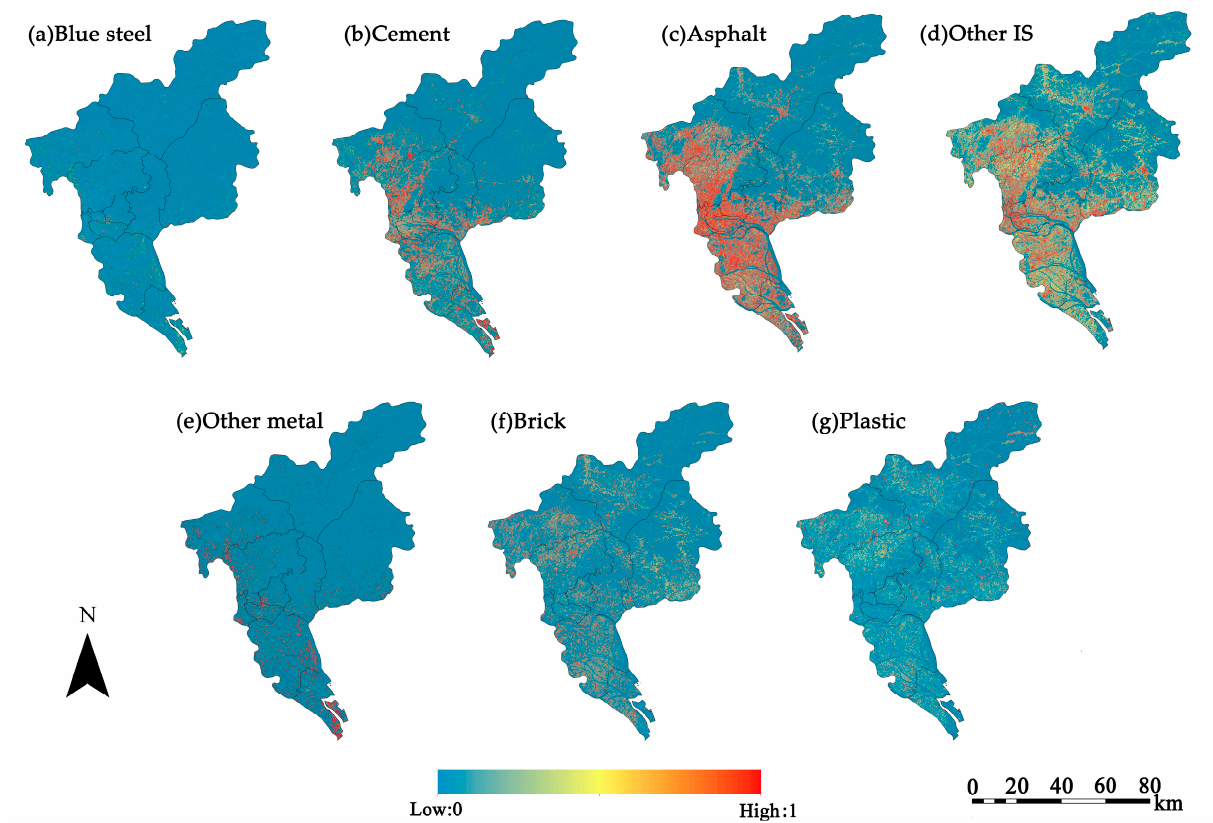
Figure 7. Fractions of finer IS classes ( a ) blue steel; ( b ) cement; ( c ) asphalt; ( d ) other impervious surface; ( e ) other metal; ( f ) brick; ( g ) plastic.